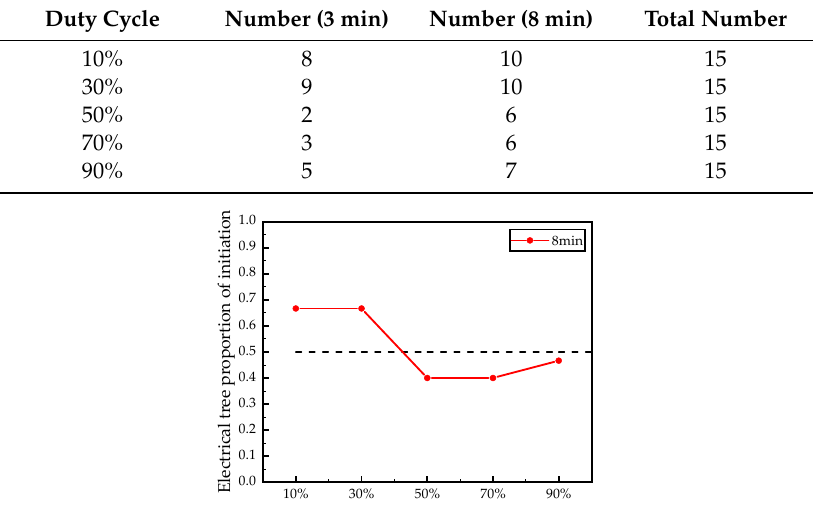
Figure 3. Electrical tree initiation proportion versus testing time under square wave voltage with different duty cycles (12 kV/1 kHz).